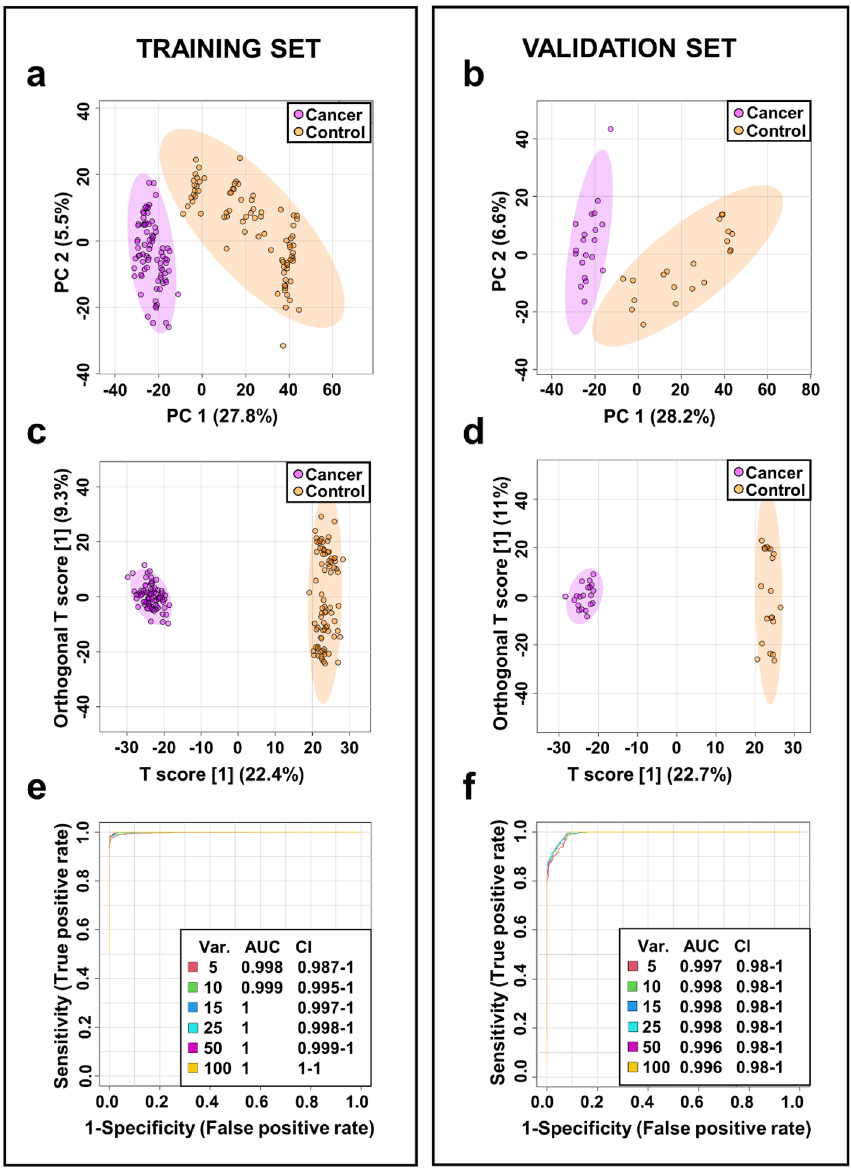
Figure 1. Metabolomic analysis of serum samples from BC and NCs. PCA and OPLS-DA scores plots of the tumor (violet) and control (orange) serum samples in the training set ( a , c ) and validation set ( b , d ). The receiving operator characteristic (ROC) curves in the training set ( e ) and validation set ( f